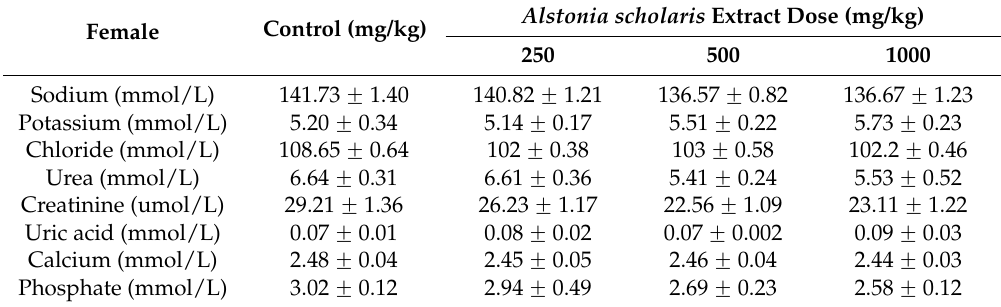
Table 3. Plasma electrolytes values in the female rats in the sub-acute toxicity study of the methanolic extract of Alstonia scholaris bark. Results were expressed as the mean ˘ S.E.M. of 5 rats.